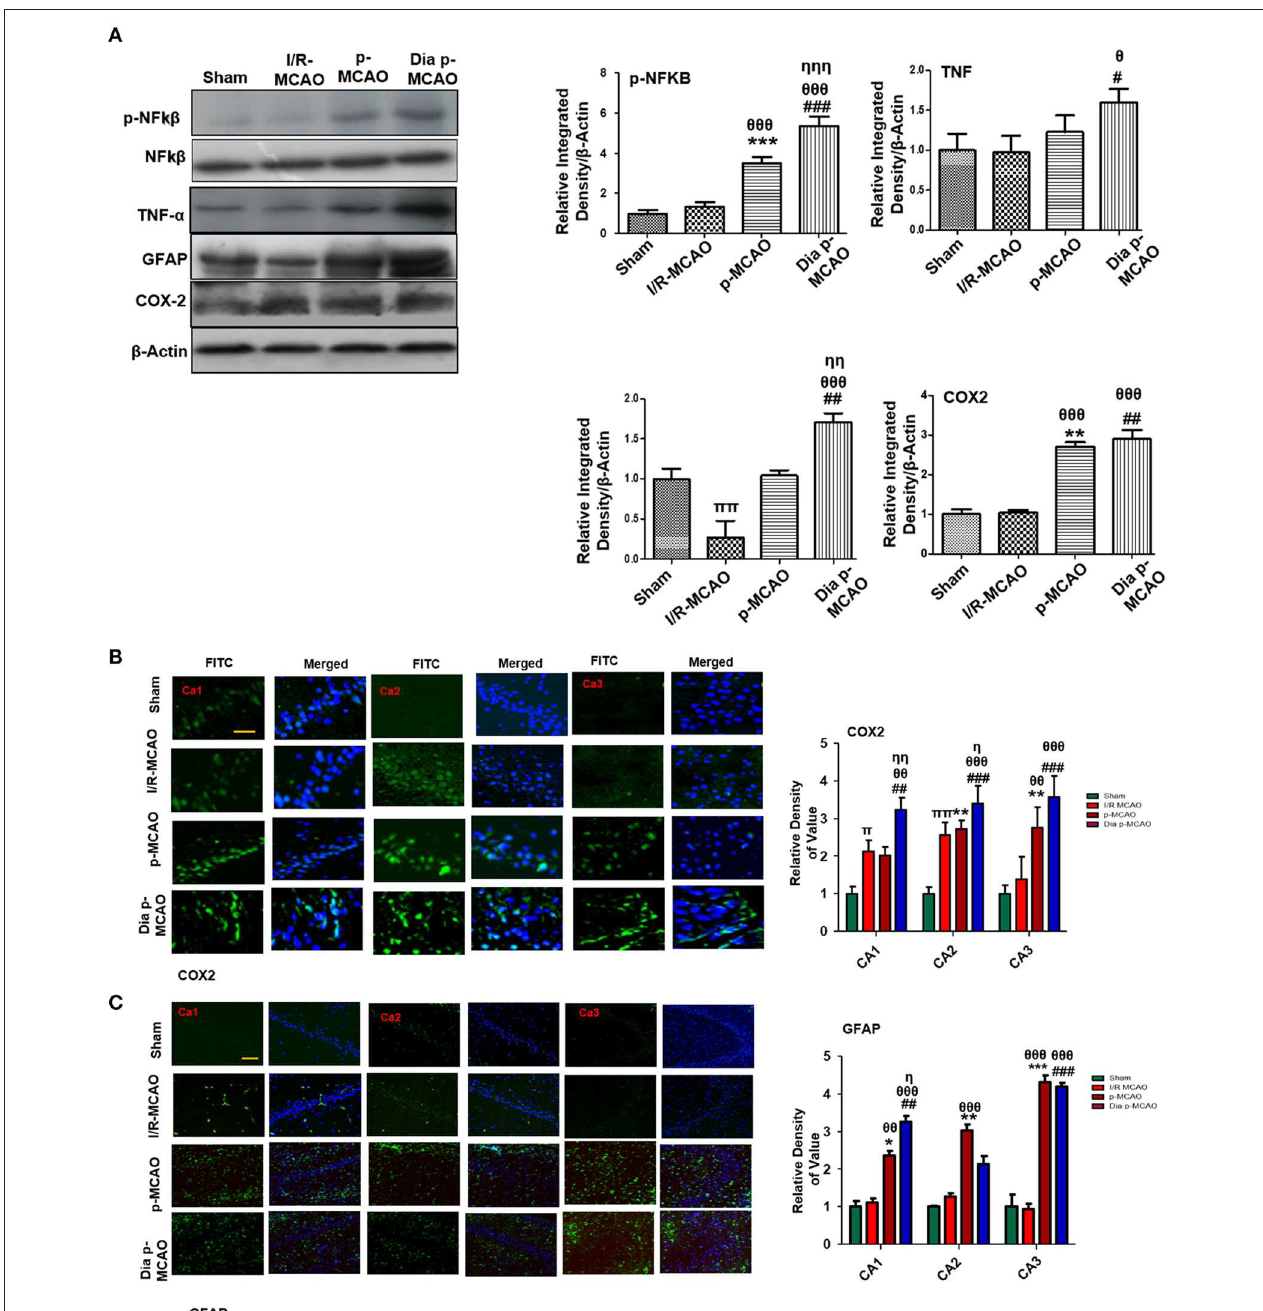
FIGURE 5 | Effect of ischemia on inflammatory related molecules in the hippocampus (A) Western blot analysis of p-NF κ B, NF κ B, TNF α , GFAP, and COX2. Densitometric analysis was expressed in relative to β -Actin ( n = 5/group). (B) Representative photos of immunohistochemistry for COX2, scale bar = 100 µ m, and (C) GFAP; scale bar = 30 µ m, ( n = 5/group). The CA1, CA2, and CA3 segments in p-MCAO and Dia p-MCAO showing elevated expression of COX2 and GFAP. θ p < 0.05 relative to I/R MCAO, η p < 0.05 between p-MCAO and Dia p-MCAO. * p < 0.05, # p < 0.05, and π p < 0.05 relative to sham group. *** p < 0.001, ** p < 0.01, ### p < 0.001, and ## p < 0.01. θθ shows significant difference of p-MCAO and Dia p-MCAO to I/R, and its value is p < 0.01, θθθ shows significant difference of p-MCAO and Dia p-MCAO to I/R, and its value is p < 0.001, ηη shows significant difference between p-MCAO and Dia p-MCAO, and its value is p < 0.01, ηηη shows significant difference between p-MCAO and Dia p-MCAO, and its value is p < 0.001, ππ shows significant difference of I/R MCAO to sham, and its value is p < 0.01.